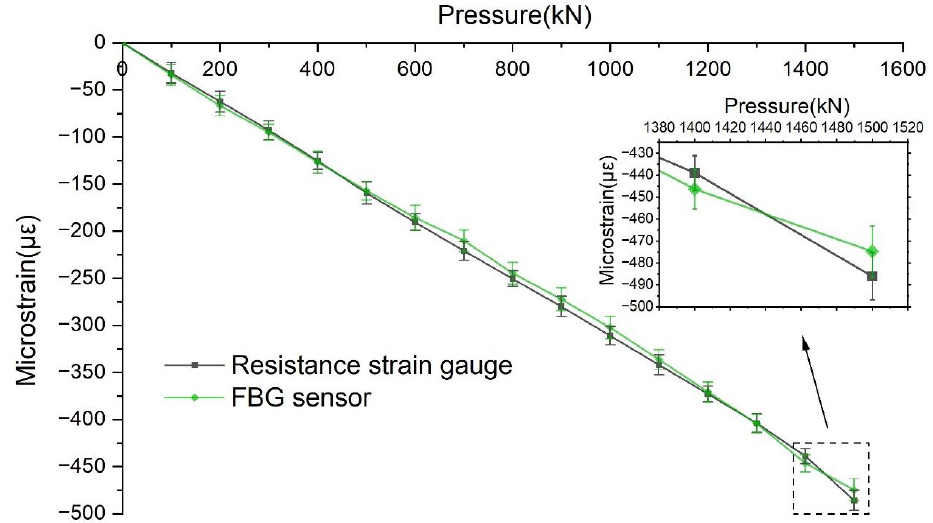
Figure 7. Comparison between curve of transverse strain of FBG sensor and resistance strain gauge.